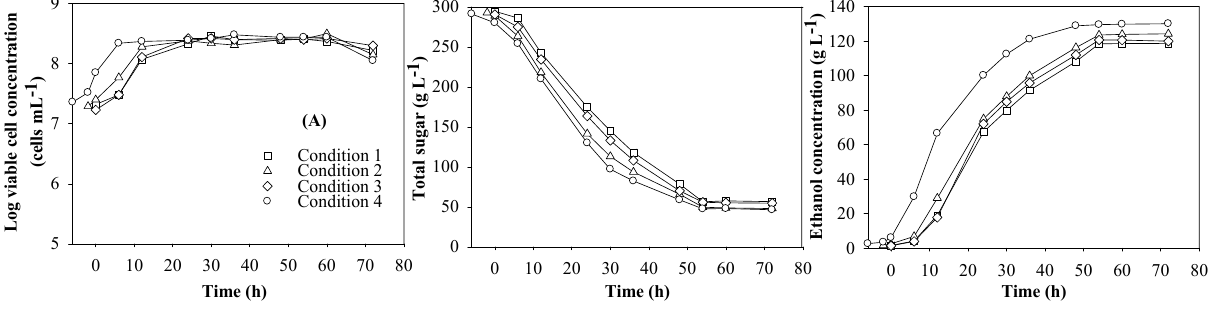
Figure 2. Batch ethanol fermentation from the sweet sorghum juice supplemented with 9 g L − 1 of yeast extract under the four conditions (see Table 1) of the preliminary experiments: ( A ) = log viable cell concentration; ( B ) = total sugar and ( C ) = ethanol concentration.